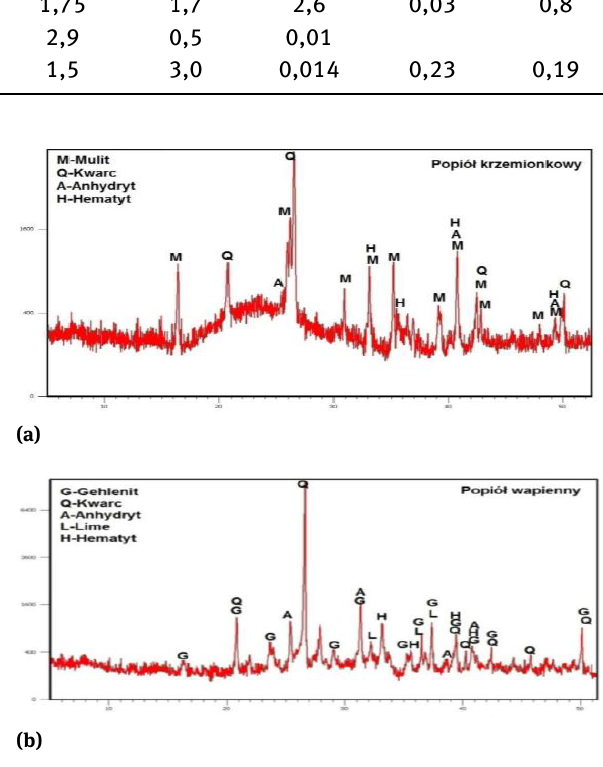
Figure 1: X-ray diffractogram of (a) low calcium fly ash, (b) high calcium fly